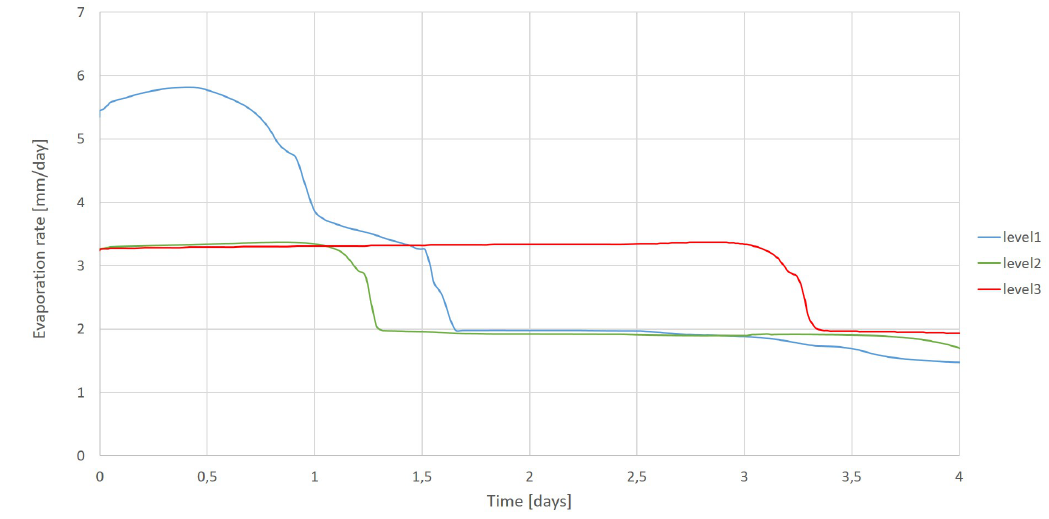
Figure 18. Comparison of the evaporation rate for different water table levels.